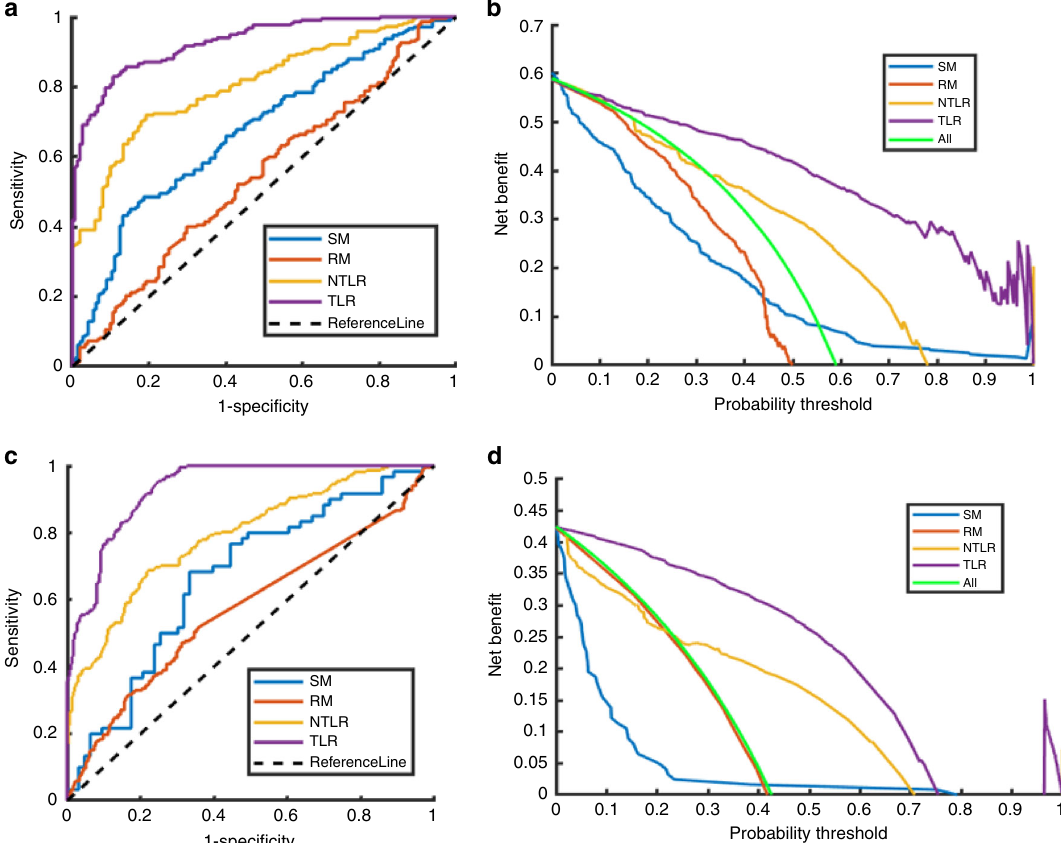
Fig. 3 Comparison of ROC curves and decision curves of LNM prediction in the two independent testing cohort by four models. a , c ROC curves in the independent testing set 1 and 2, respectively. b , d Decision curves in the independent testing set 1 and 2, respectively. (SM statistical model, RM traditional radiomics model, NTLR nontransfer learning radiomics, TLR transfer learning